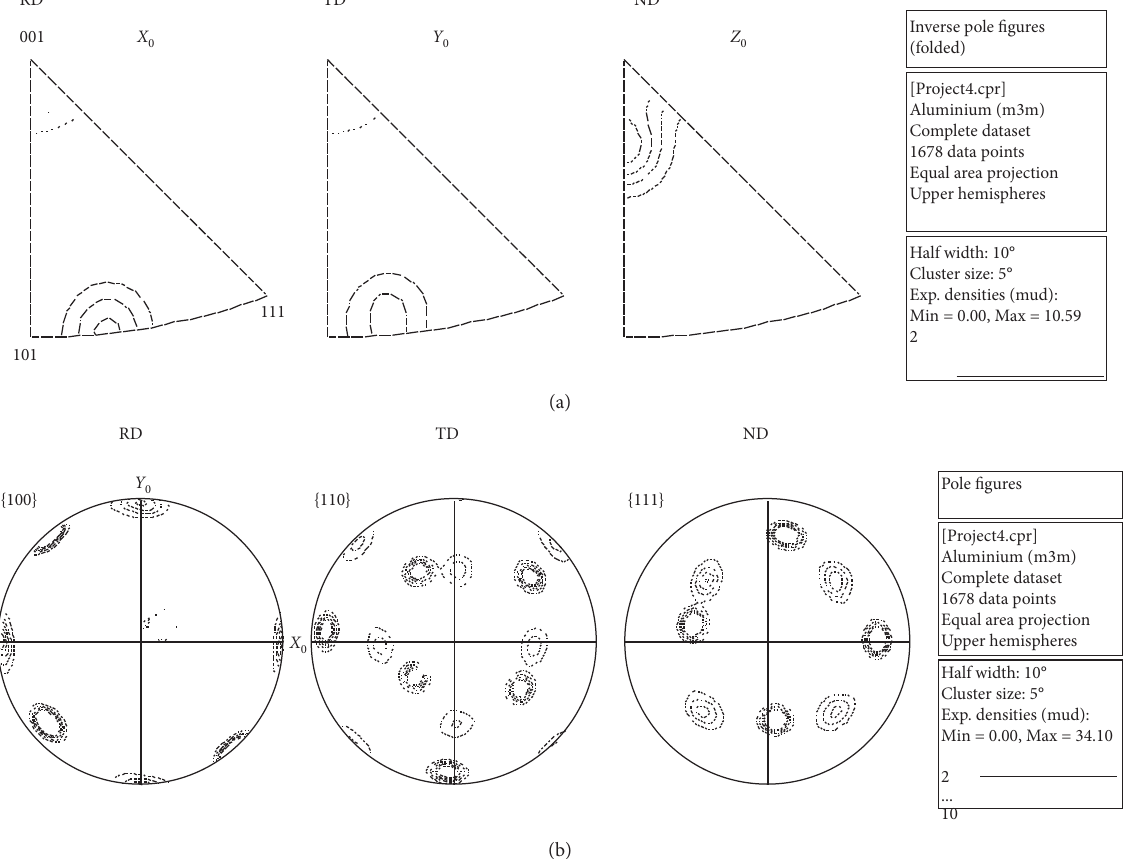
Figure 9: Pole figure and inverse pole figure near the abnormal grain boundary: (a) IPF; (b)